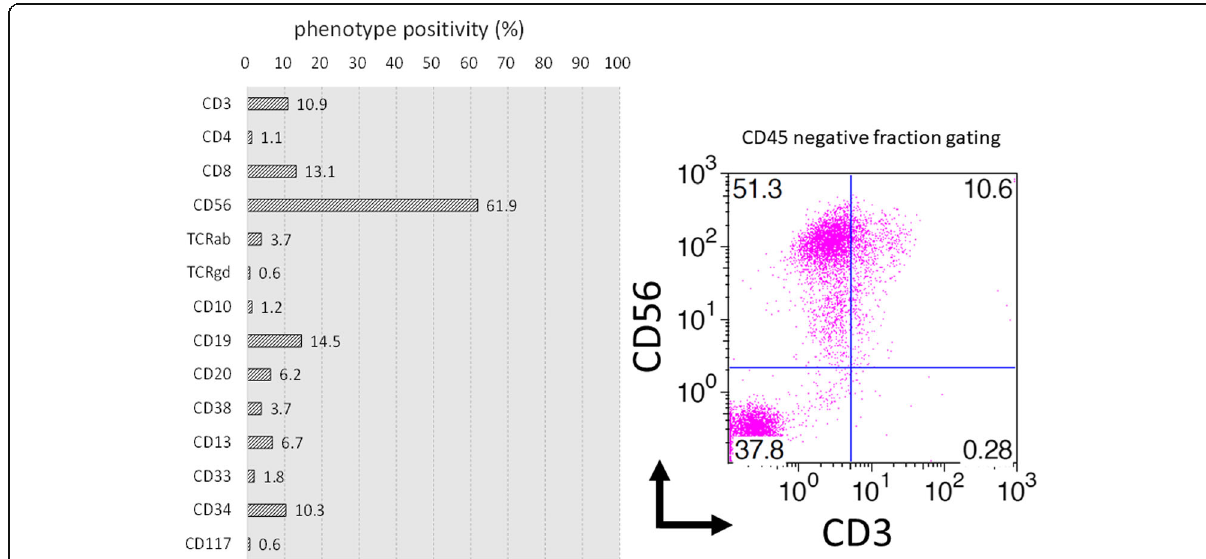
Fig. 3 Flow cytometry of bone marrow Flow cytometry analysis indicated that the infiltrating tumor cells were phenotypically positive only for CD56. The indicated proportions of cells in each phenotype were the percentages of the CD45-negative fraction